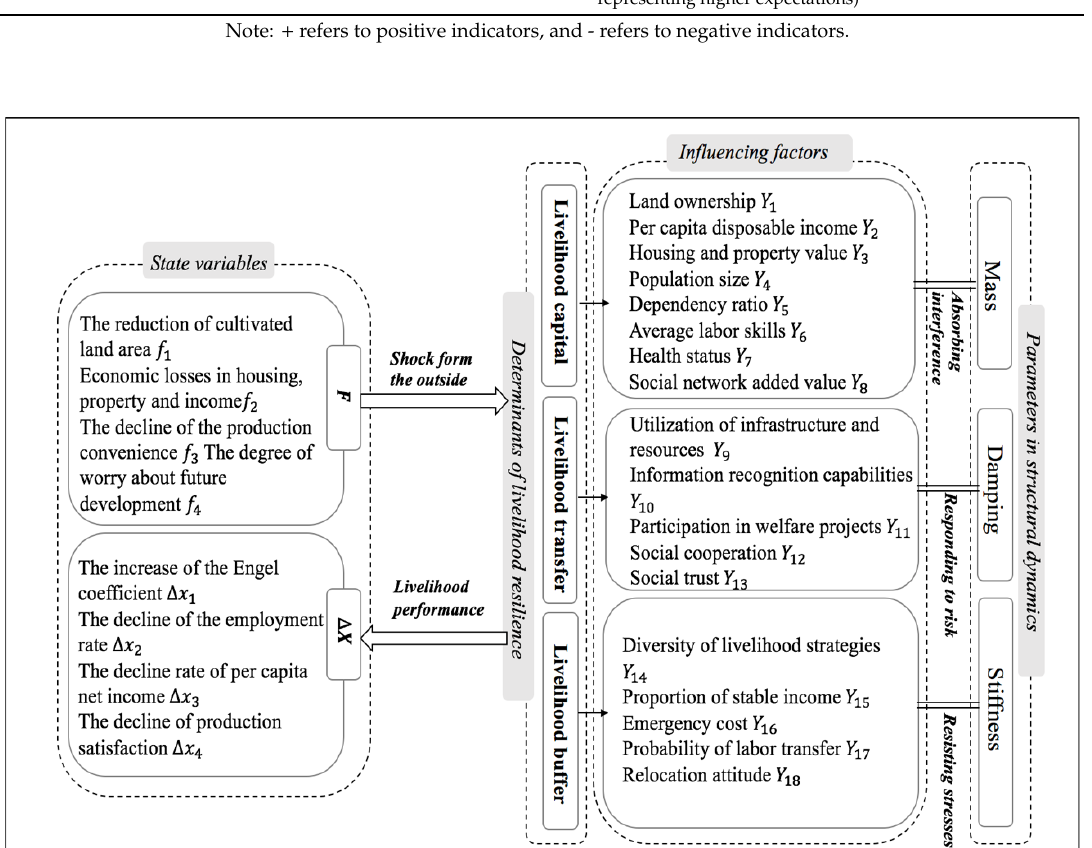
Table 1. Factors influencing livelihood resilience. 297